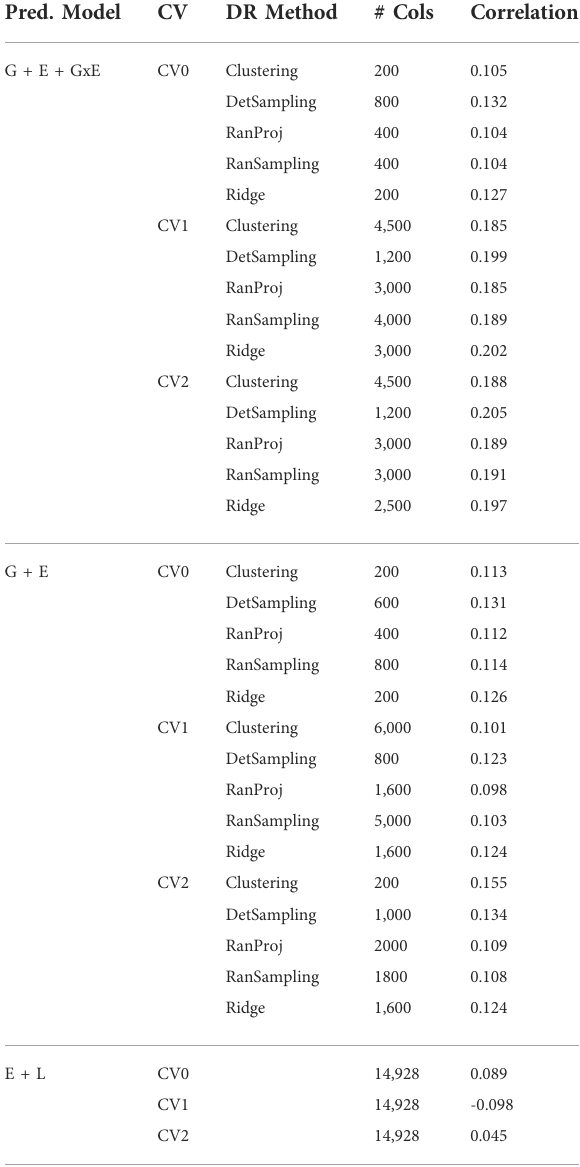
TABLE 1 Number of markers selected by each dimensionality reduction (DR) method to obtain 95% of the highest correlation for the three prediction models (G + E + GxE, G + E, E + L) under the three cross-validation schemes (CV0, CV1, CV2). Pred.